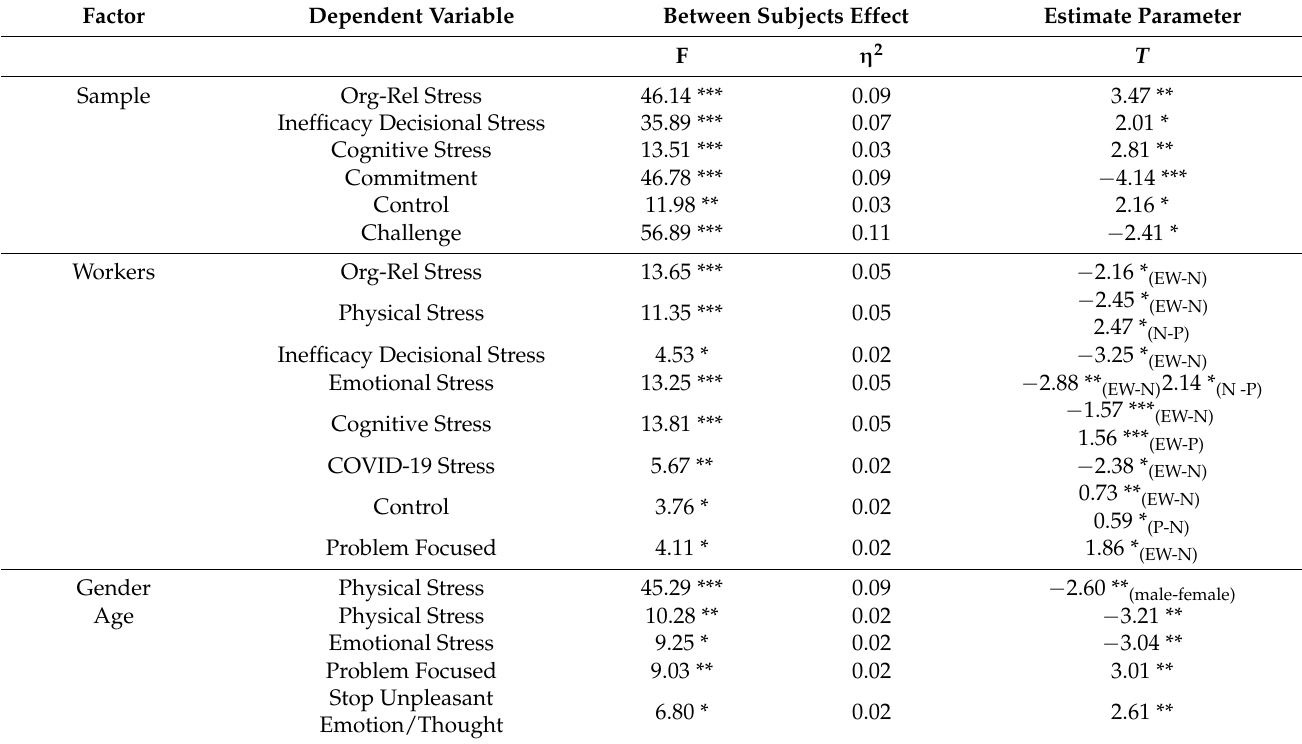
Table 3. Between-subjects effects of multivariate analysis of variance (MANOVA) for sample, workers, gender and age on stress levels, coping strategies and hardiness scales (n = 500) 1 . Factor Dependent Variable Between Subjects Effect Estimate